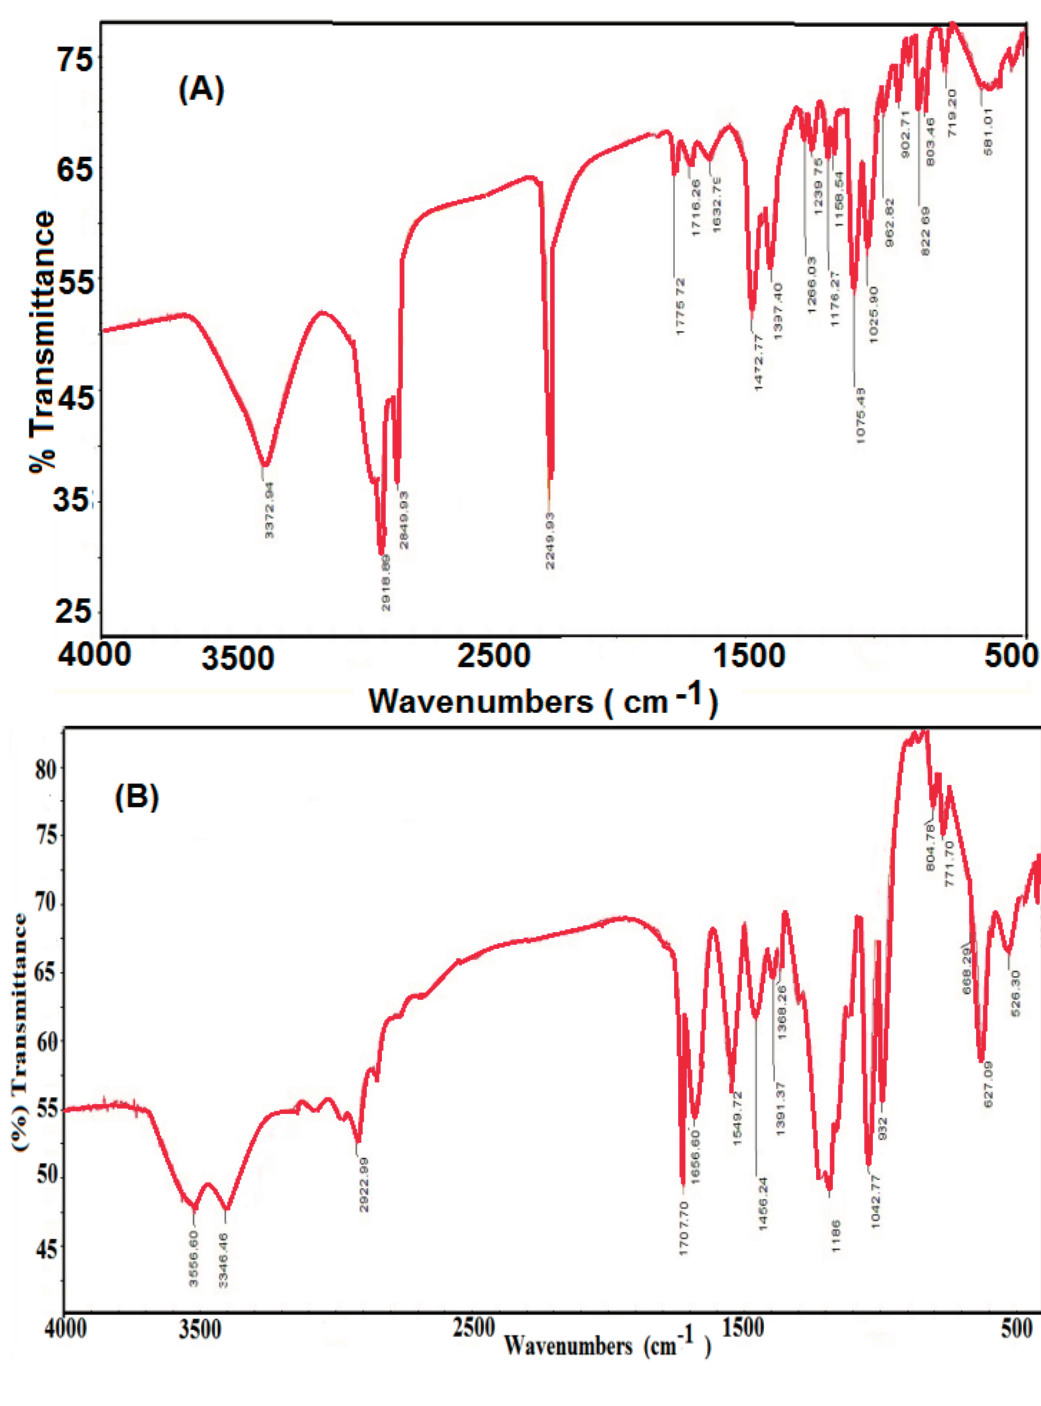
Figure 1. FTIR spectra of ( A ) R-AN and ( B ) RK-AN amidoxime